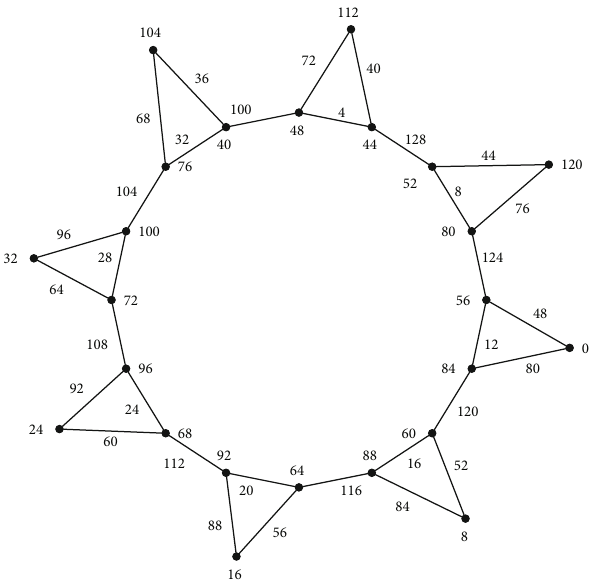
− 16 Þ with an edge 4